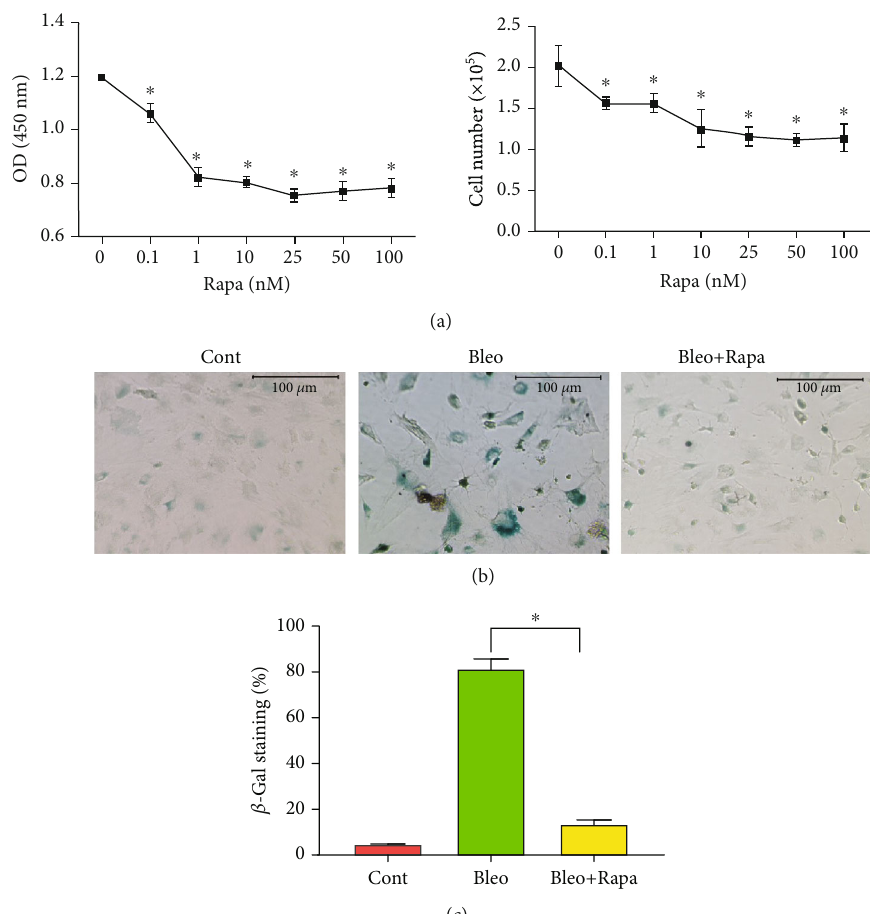
Figure 2: Rapamycin decreases PTSC senescence. (a) Treatment of PTSCs with rapamycin reduces cell proliferation. Data are presented as the mean ± SD , triplicates. ∗ p < 0 : 01 compared to the control group without rapamycin treatment. (b) Treatment of PTSCs with 50 μ g/ml bleomycin induces β -gal, but it is abolished by combined treatment with 25 nM rapamycin for 5 days. Scale bar = 100 μ m . (c) Semiquanti fi cation con fi rms that rapamycin blocks β -gal induced by bleomycin. Results are expressed as mean ± SD , n = 3 . ∗ p < 0 : 01 , compared to the bleomycin treatment group. Cont: control; Bleo: bleomycin; Rapa: